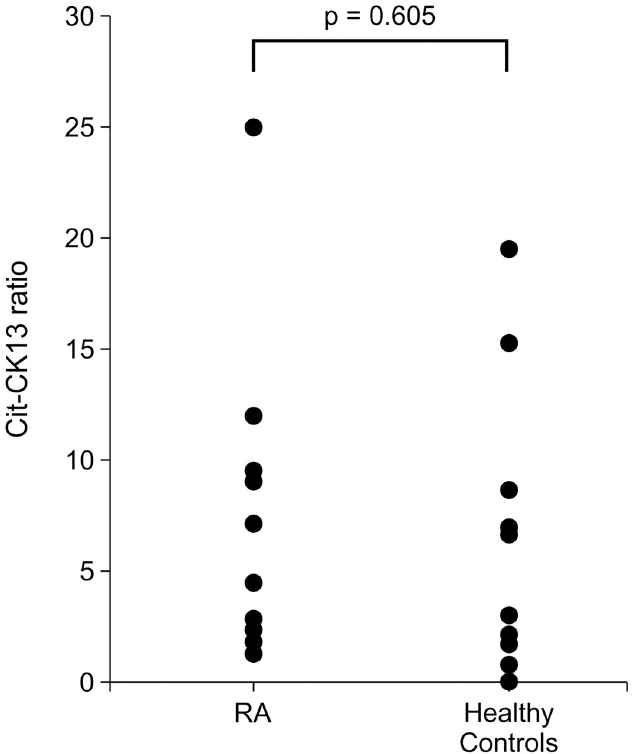
Fig 6. Distribution of citrullinated cytokeratin 13 (Cit-CK13) ratio in the saliva of patients with rheumatoid arthritis (RA) and healthy participants. The signal intensities of bands corresponding to cytokeratin 13 (CK13) and Cit-CK13 in saliva samples were measured. The same saliva sample was used as a standard sample for each immunostaining experiment, and the signal intensity ratio was calculated by dividing the signal intensities of the CK13 and Cit-CK13 bands of each saliva sample by the signal intensity of the standard sample. The Cit-CK13 ratio was calculated by dividing the signal intensity ratio of the Cit-CK13 band by that of the CK13